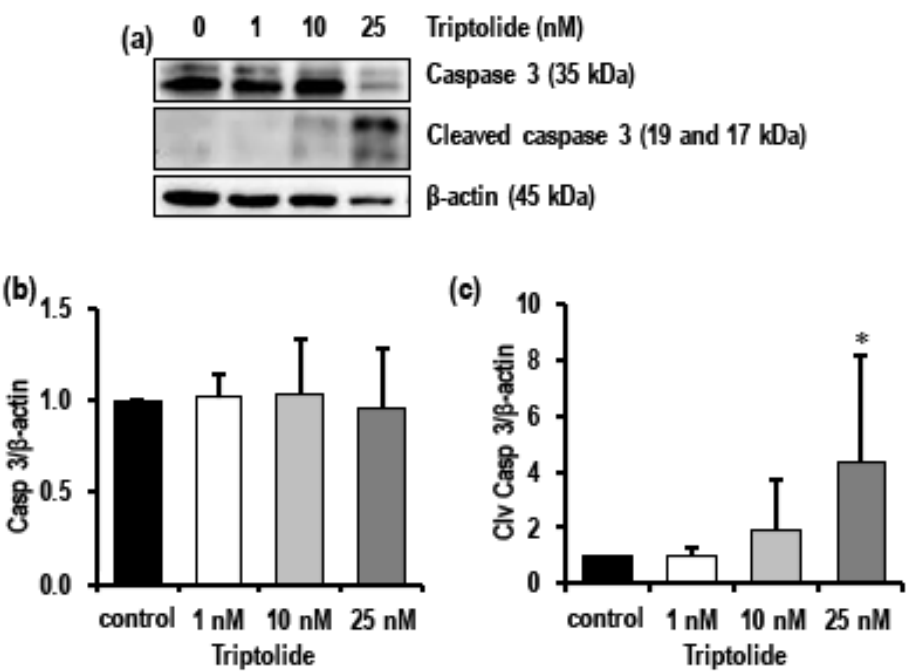
Figure 6. Effect of triptolide on the levels of caspase 3 and cleaved caspase in MDA-MB-231 cells after 72 h of triptolide treatment. ( a ) Representative Western blots show the levels of total caspase 3 and cleaved caspase 3 in MDA-MB-231 cells treated with varied concentrations (1, 10, and 25 nM) of triptolide for 72 h. ( b , c ) Bar graphs indicate the levels of caspase 3 and cleaved caspase 3 in triptolide-treated MDA-MB-231 cells. β -actin was used as loading control. Values are expressed as mean ± SD from four to five experiments. An increase in the level of cleaved caspase 3 in the treatment group indicated activation of apoptosis. Density was normalized to β -actin and the ratio was calculated against untreated control.